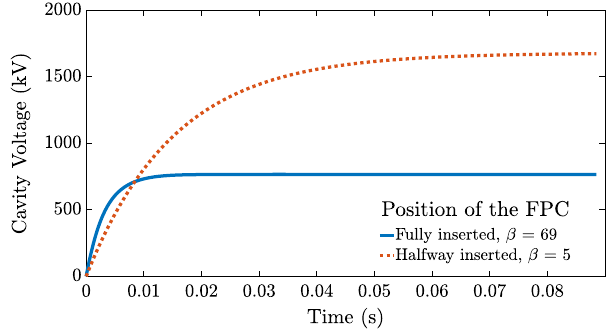
FIG. 18. Impact energy of the secondary electrons based on the results of the 1st order multipacting simulation using ACE3P.